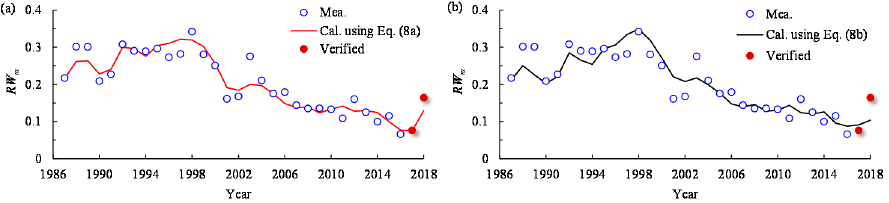
Figure 15. Comparisons between the measurements and the reach-scale channel centerline migration intensities calculated using: ( a ) Equation (8a); ( b ) Equation (8b).